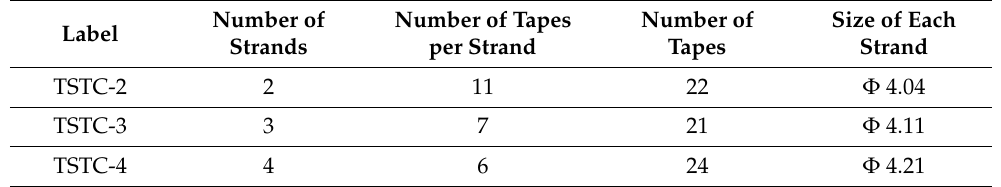
Table 1. Multi-strand TSTC scheme.